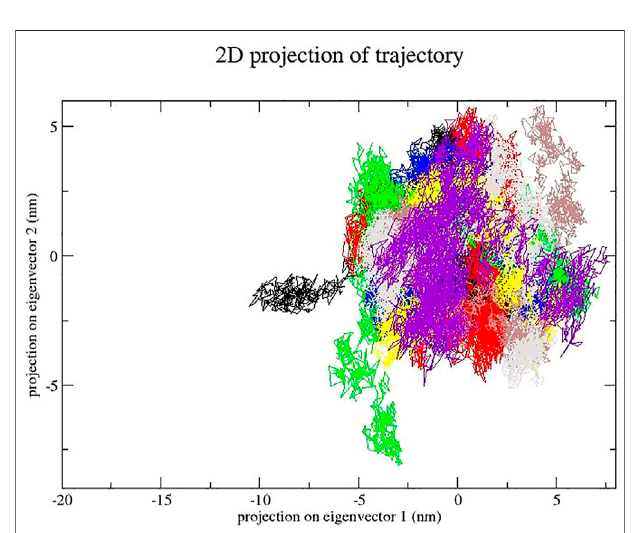
FIGURE 8 | Principal component analysis. Projection of the motion for compounds (red) GA, green) CA, blue) TQ, yellow) Betanin, brown) Betanidin, gray) Ebselen, purple) Fisetin, and black) free-SENP2. in phase space along the PC1 and